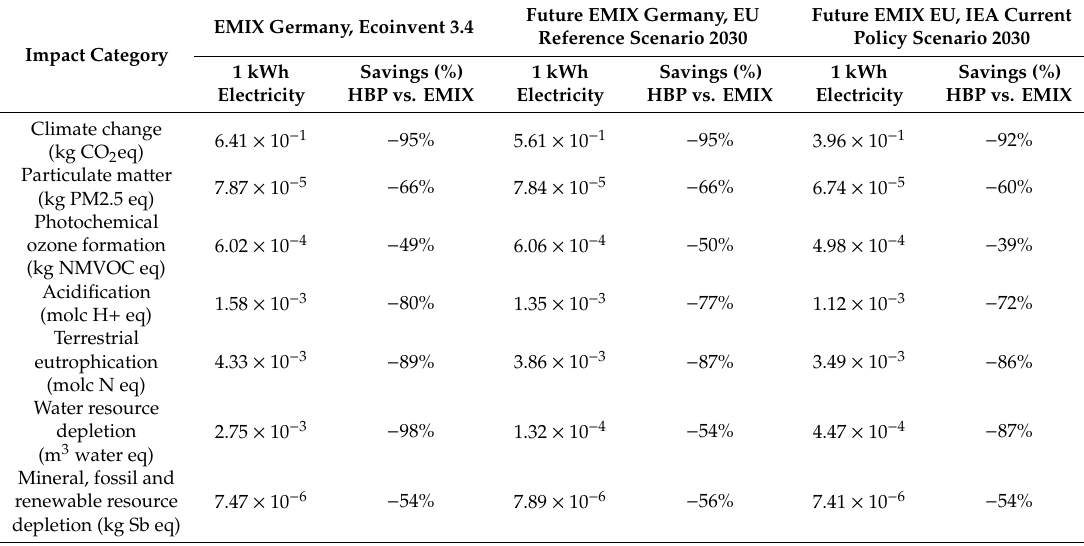
Table 6. Sensitivity analysis on the savings of environmental impacts of 1 kWh of electricity produced by the HBP compared to the grid electricity mix